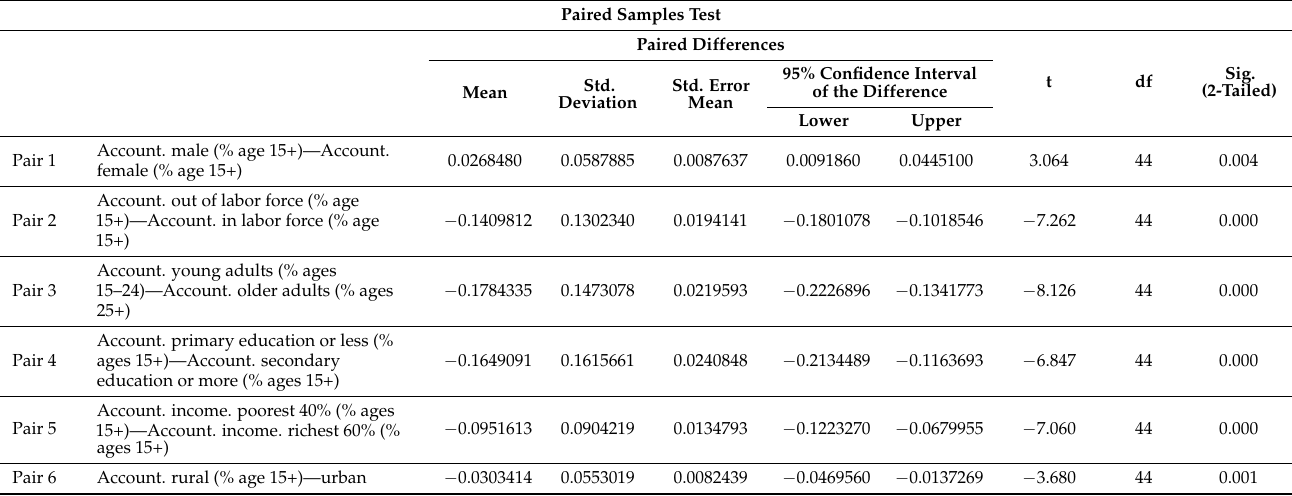
Table 3. Testing the differences between groups. Paired Samples